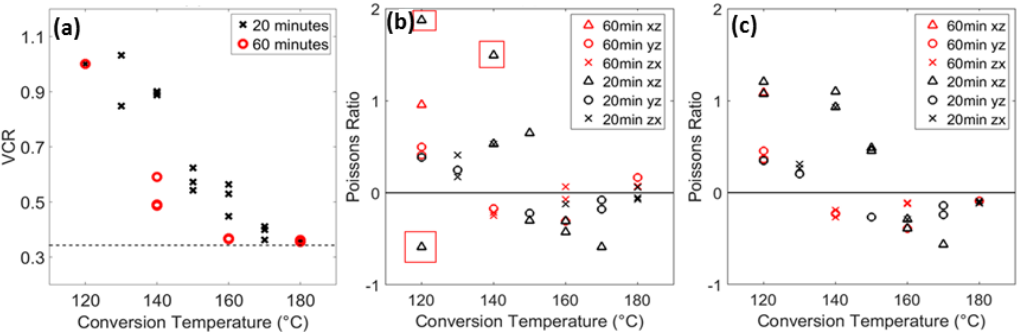
Figure 2. ( a ) Measured VCR (dashed line = imposed VCR); ( b ) Compressive and; ( c ) Tensile Poisson’s ratio, (key showing conversion times & orientation, subscript = axial & transverse directions respectively (Figure 1a) red boxes show